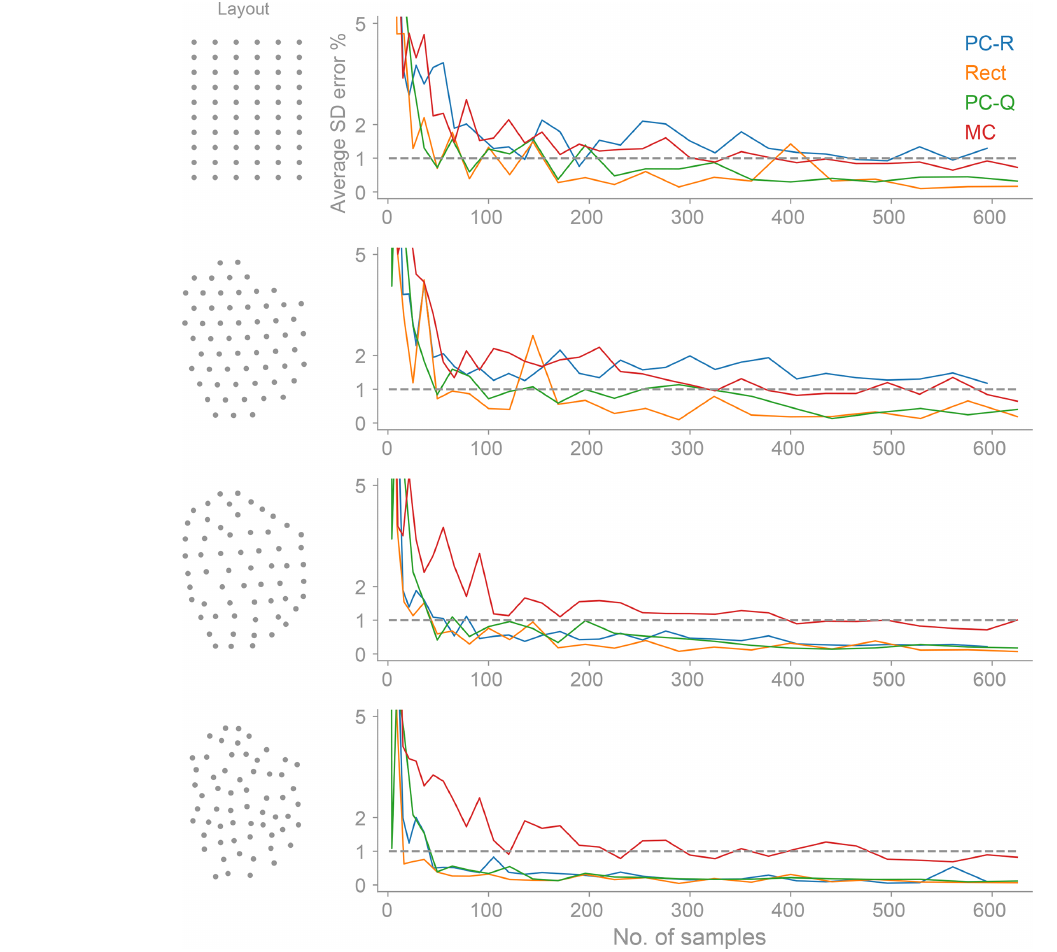
Figure 7. The average standard deviation of the energy (SD) error as a function of the number of samples for polynomial chaos (based on regression and quadrature), the rectangle rule, and Monte Carlo. The SD is a function of two uncertain variables: the wind direction and wind speed. Note that the PC-R response is biased for the Grid and Amalia layouts. The PC-R underpredicts the true SD at the expense of computing the mean (AEP) more accurately (see Fig.